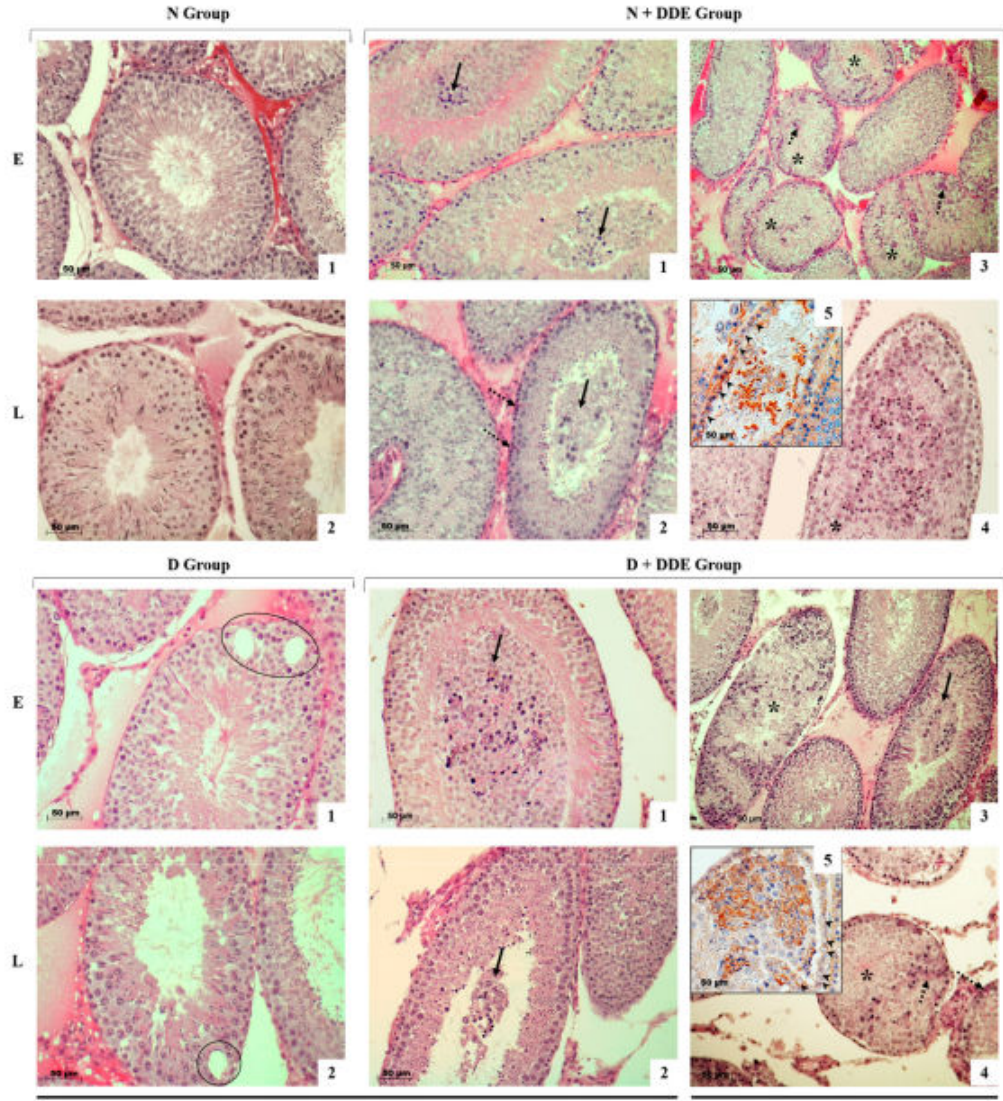
Figure 7. Histological analysis of the tubules of control rats (N group, panels 1–2) showed the sequence of germ cell generation at the stages E (I-VIII) and L (IX-XIV). In D group, some tubules present in the seminiferous epithelium vacuolated and empty areas (panels 1–2, black circles). In DDE-treated rats (N + DDE and D + DDE, panels 1–5), a lot of tubules exhibited the lumen filled with non-di ff erentiated cells mainly round spermatids in E stages along with spermatocytes in L stages (arrows). Severe cellular depletion in some tubules was detected and showed as in the figure for cleaved caspase 3 immunostaining in both N + DDE and D + DDE groups (both panels 5, arrowheads) where, in a predominant way, only Sertoli cells were detectable in the tubular wall. Tubules with a contracted lumen size and strong disorganization of the seminiferous epithelium were found (asterisks). Eosinophilic cells were also detected (dashed arrows). Scale bar 50 µ